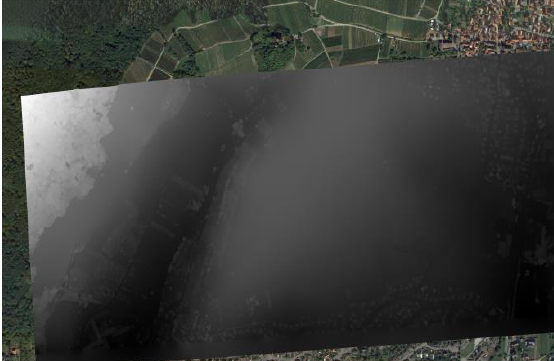
Figure 5. The DSM of the entire study area overlaid on the orthophoto.